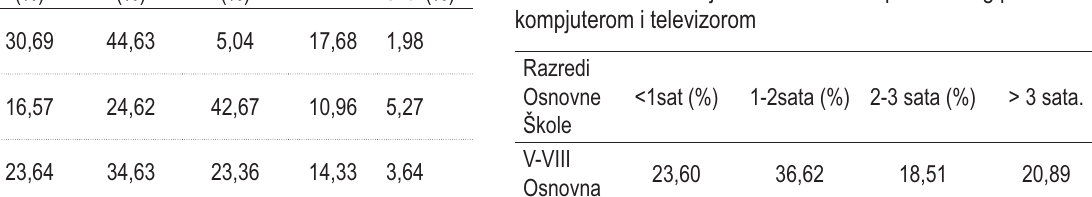
TABELA 5. Distribucija dužine vremena provedenog